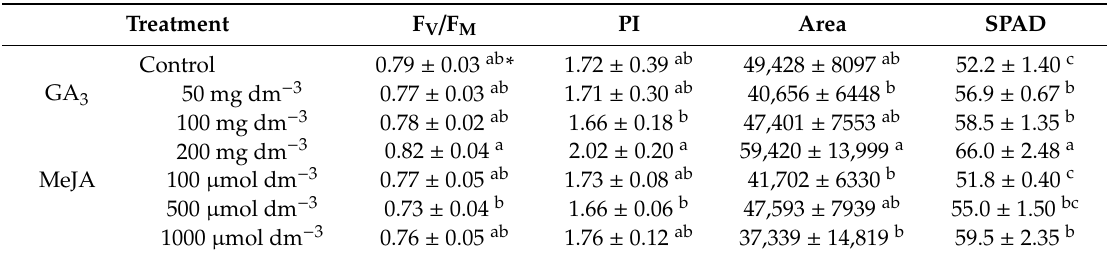
Table 5. E ff ects of GA 3 and MeJA on chlorophyll fluorescence parameters (F V / F M, PI, Area) and leaf greenness index (SPAD) in × A. tubergenii “Zwanenburg”